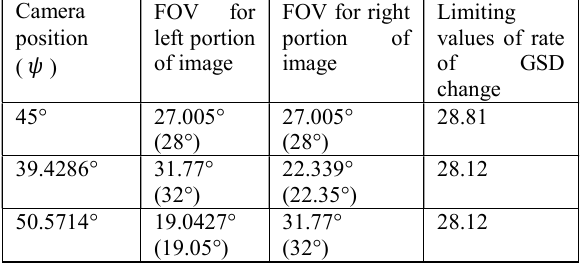
Table 2. FOV values corresponding to critical values of rate of GSD change for three camera positions